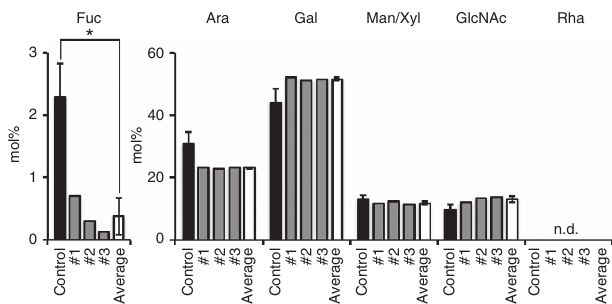
Figure 7 | Protein fucosylation in hp GFT1 lines. Monosaccharide content (mol %) of trifluoroacetic acid-hydrolysed total protein extracted from hp GFT1 lines measured by anion exchange chromatography. The control values are mean and s.d. of four independent analyses ( n ¼ 4). The values for the hp GFT1 lines represent the mean of each cohort analysed in triplicate. The ‘average’ is the mean and s.d. ( n ¼ 3) of data from the three independent hp GFT1 cohorts. Fuc levels are significantly different ( P o 0.0004) by Student’s t -test, as were the sugars Ara ( P o 0.009), Gal ( P o 0.02), Man/Xyl ( P o 0.03) and GlcNAc ( P o 0.005) to a lesser